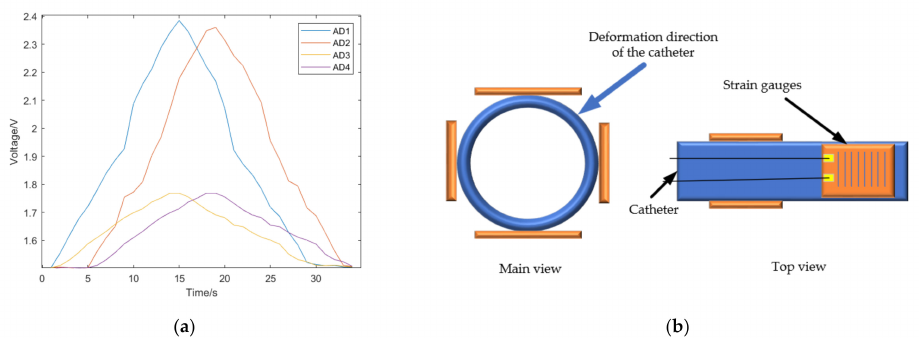
Figure 15. ( a ) The voltage change during a catheter push after rotating the catheter by 45 degrees. ( b ) The predicted deformation direction of the catheter.